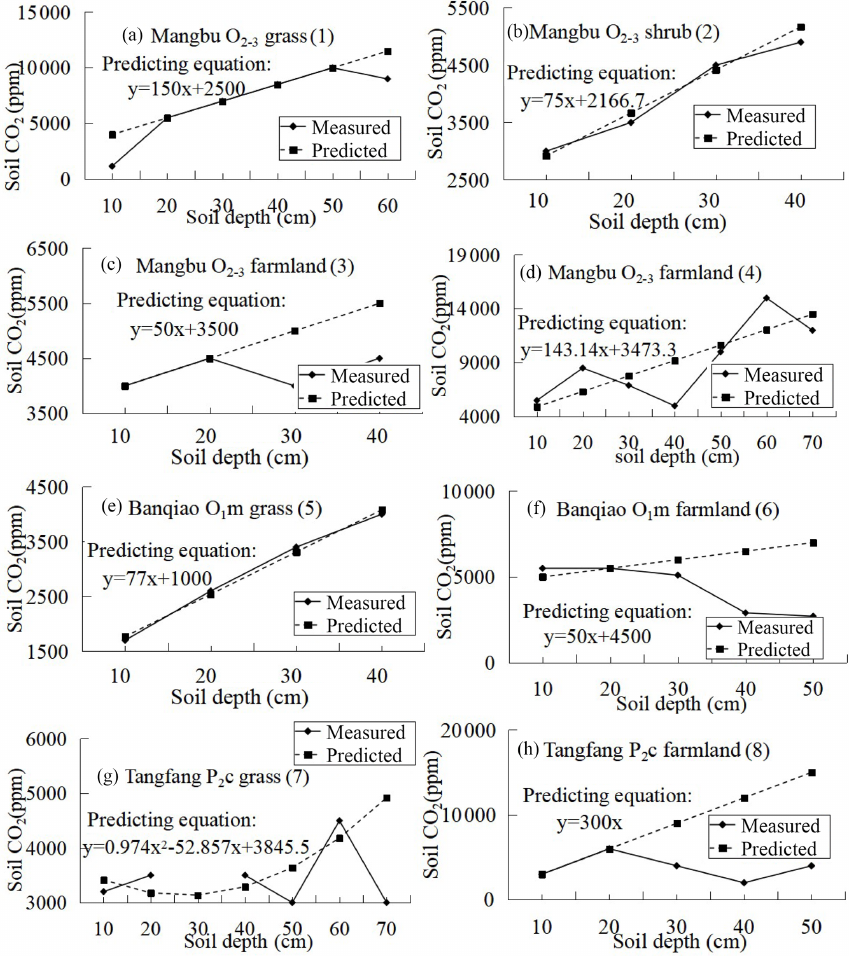
Earth Syst. Dynam., 10, 525–538,